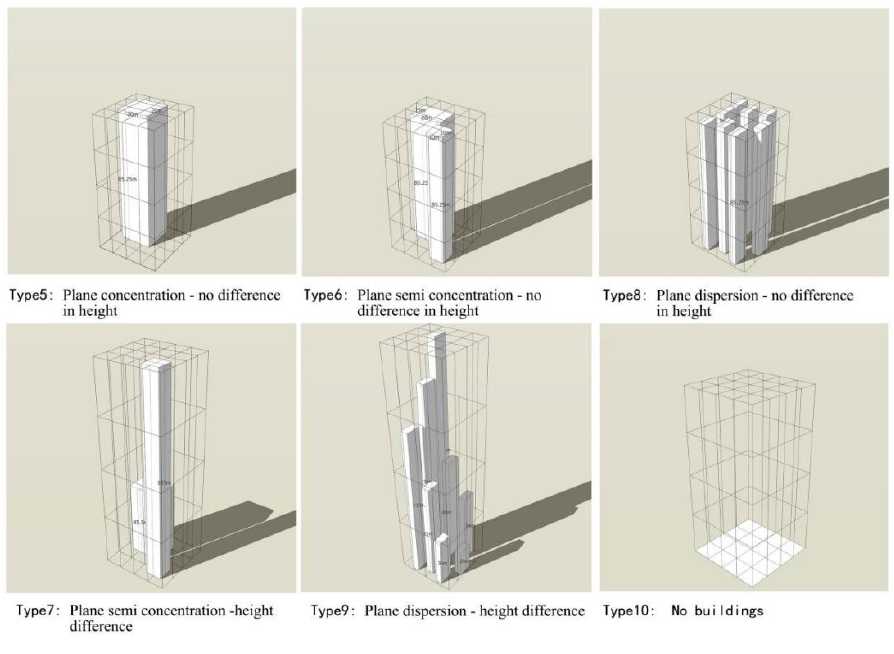
Figure 3. The basic model of the 3D building.